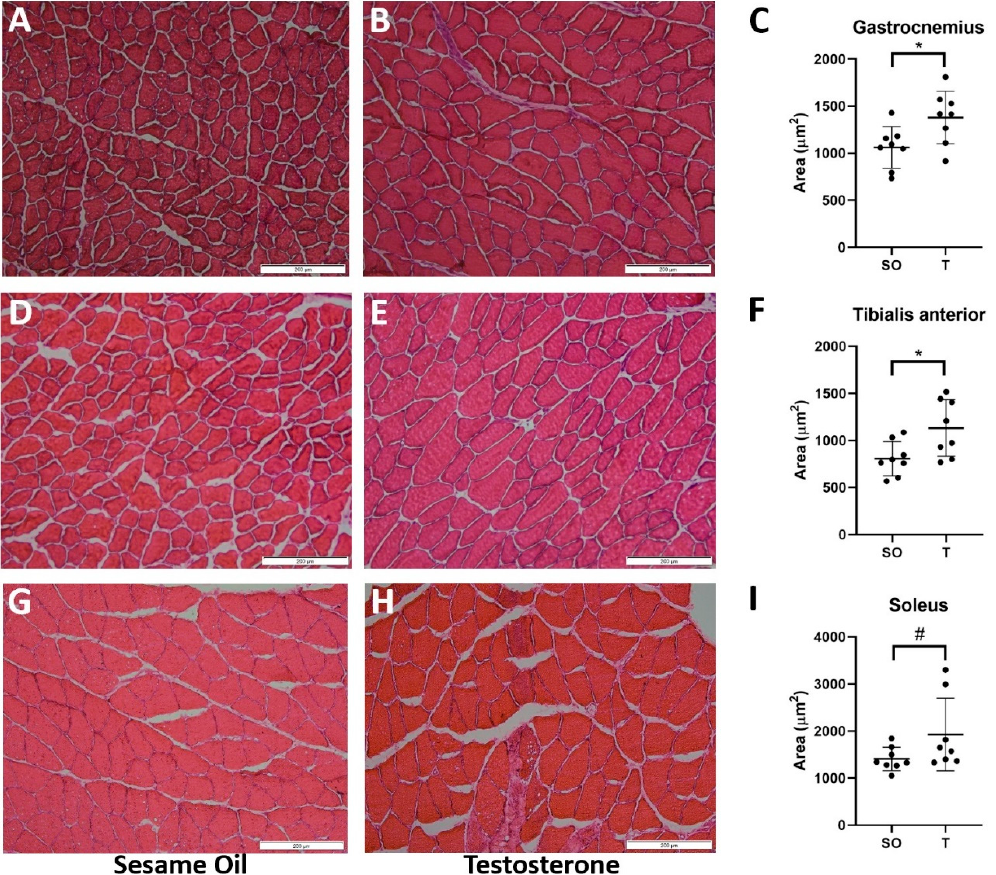
Figure 4. Greater hindlimb skeletal muscle cross-sectional area in PNA rats. At 16 weeks of age, animals were euthanized, and hindlimb muscles were carefully dissected. Gastrocnemius (GN), tibialis anterior (TA), and soleus (SOL) muscles from female rats exposed to sesame oil ( n = 8) or testosterone ( n = 8) were snap-frozen and cryosectioned at 10 µm thickness prior to fixing in paraformaldehyde and staining with hematoxylin and eosin. For each rat, 3 distinct fields per muscle sample were imaged at 200x magnification; representative images from muscles from rats prenatally exposed to sesame oil ( A , D , G ) or testosterone ( B , E , H ) are shown. Fiber cross-sectional area was measured; data were normally distributed and analyzed using unpaired t-tests ( C , F , I ). Values represent the mean ± SD. * p < 0.05, # p = 0.0924. Scale bars, 200 µm.